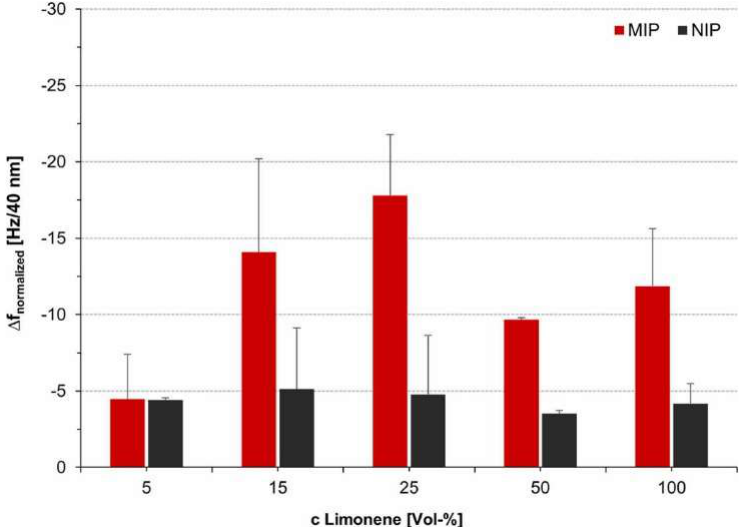
Figure 13. Effect of varying template concentration in the imprinting of limonene by Völkle et al. A total of 300 µ L of styrene and 700 µ L of divinylbenzene were combined in 1300 µ L of limonene and toluene in differing ratios. The resulting MIPs were spin–coated onto QCM sensors and studied for their response to limonene at 250 ppm. Reproduced with permission [145].